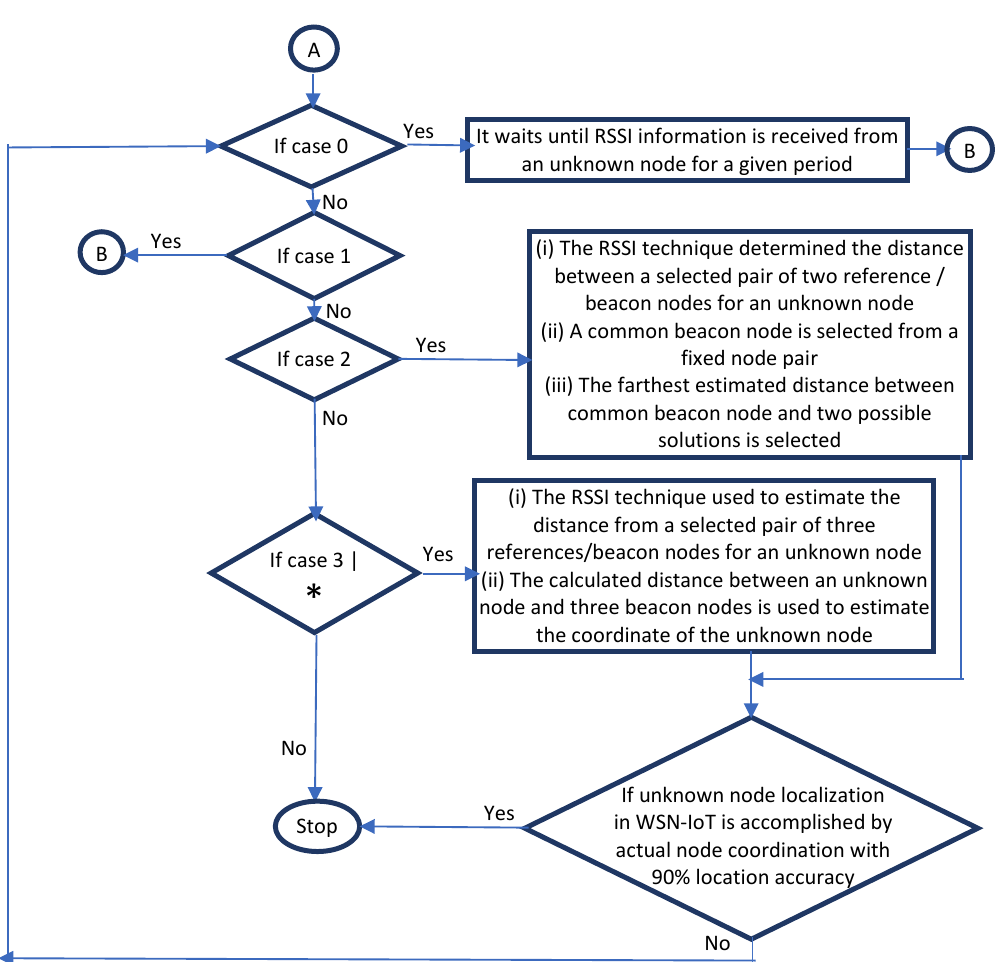
Figure 3. Flowchart of an adaptive ensemble localization approach for